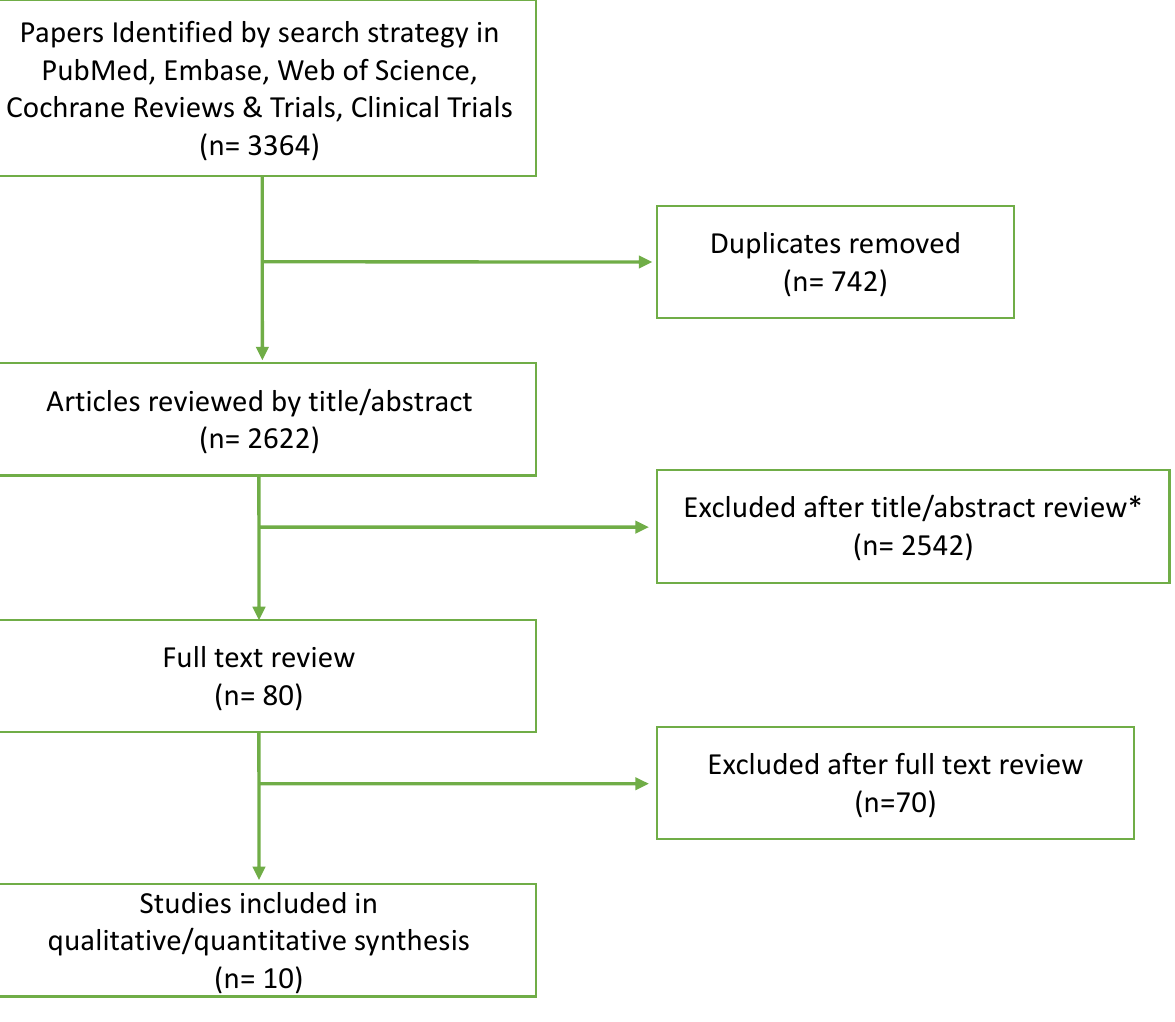
Figure 1. PRISMA diagram depicting screening process.